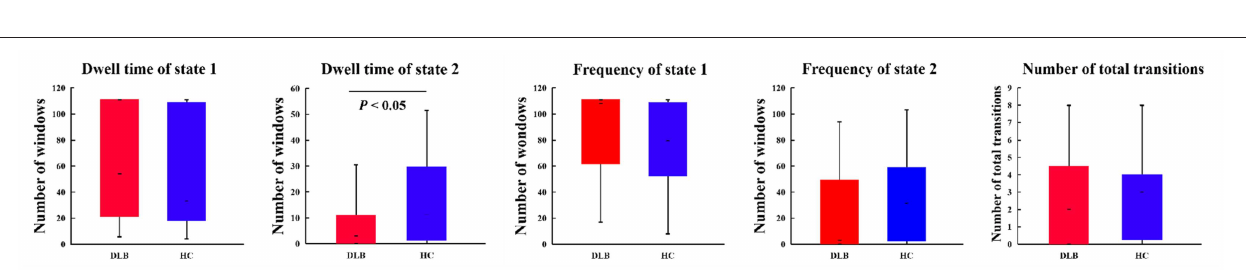
FIGURE 3 | Clustering index characteristics. Group comparison of state dwell time, occurrence frequency, and number of total transitions. The upper and lower boundaries of the box-plot represent the maximum and minimum values, the upper and lower boundaries of the box body represent the upper and lower quartiles, respectively, and the short line in the box body represents the median. p -value results from Mann–Whitney test. See Table 2 for detailed information on statistics.